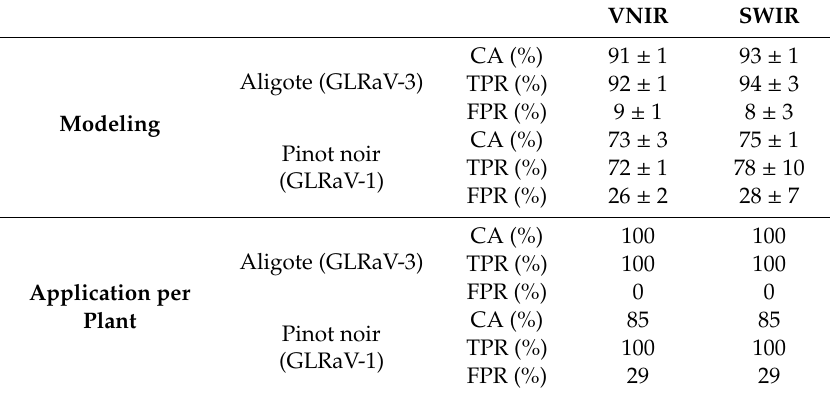
Table 8. Results for the detection of GLRaV-infected but symptomless greenhouse plants. For modeling, all pixels were evaluated not considering spatial scales. Developed models were then applied per plant using all leaves for majority